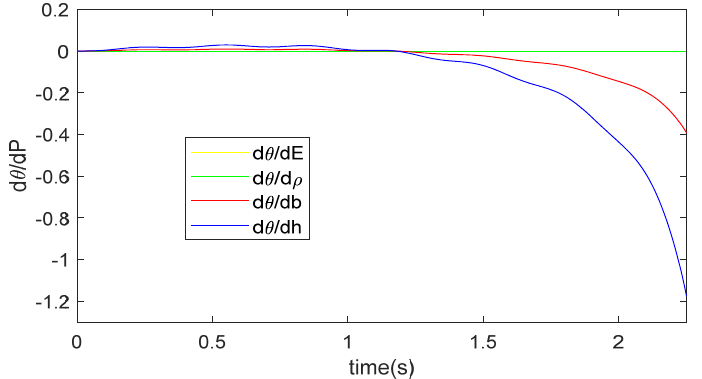
Figure 14. The sensitivity of the solution θ with respect to the design parameters E , (cid:2025) , b and h .